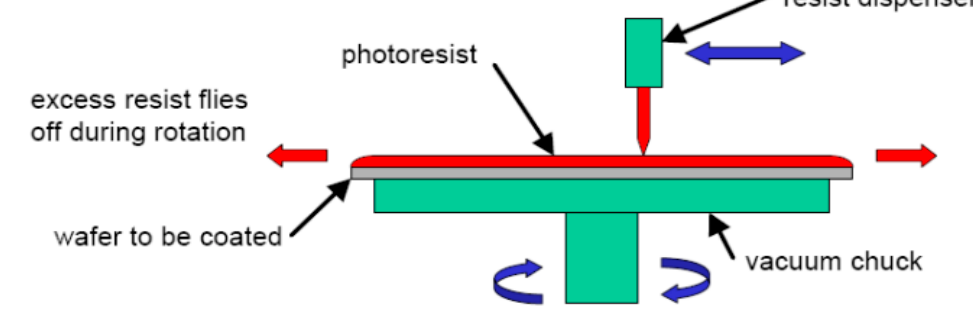
Figure 7. Illustration of hard-bake process.